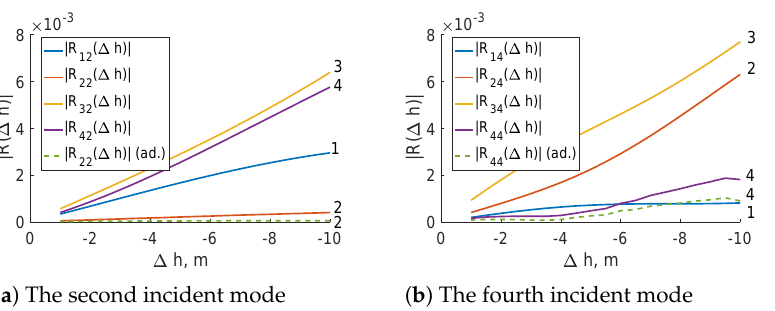
Figure 5. The reflection coefficients as functions of the minimum depth ∆ h of the